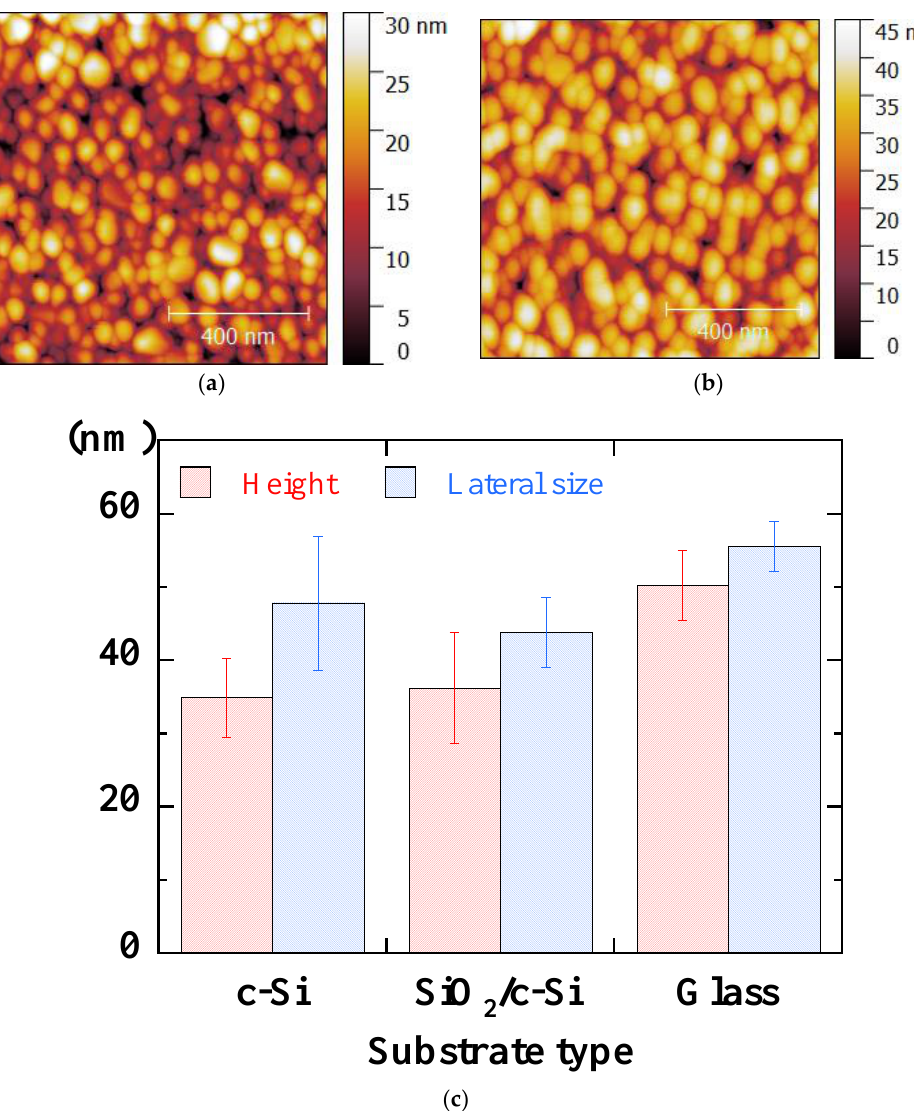
Figure 12. 1 μm × 1 μm AFM micrographs of sol -gel spin-coated ZnO thin films deposited on c-Si ( a ) and glass substrate ( b ) and AFM values obtained with the different substrates ( c ).